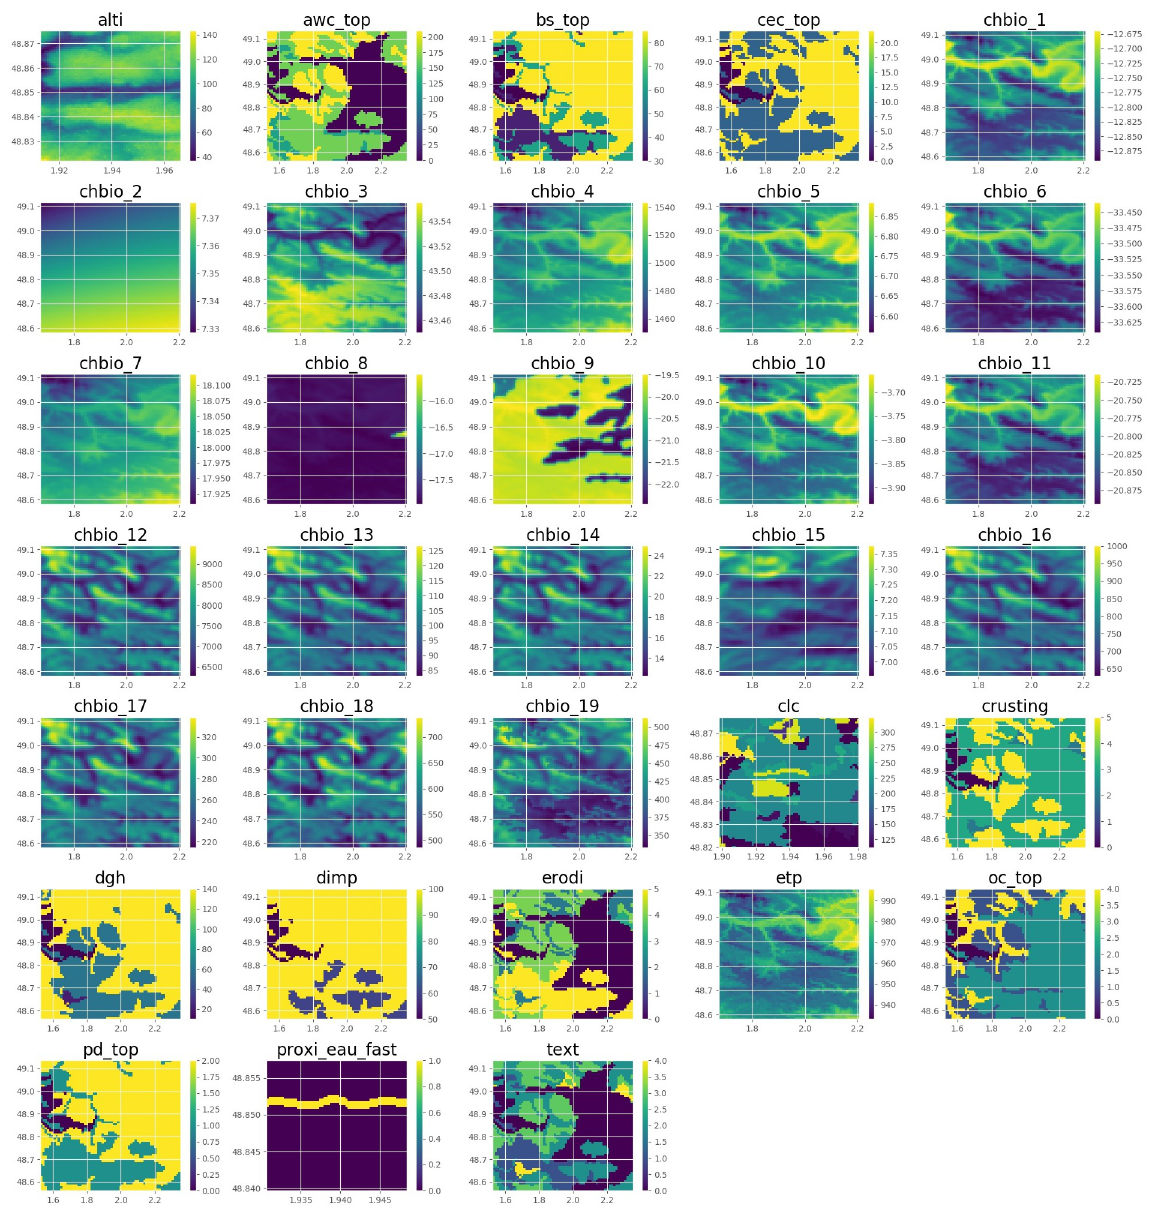
Fig 2. Tensor example. Example of tensor extracted from the 33 variables (latitude: 48.848530, longitude: 1.939530). Artificial colors from purple (lowest value) to yellow (highest value).